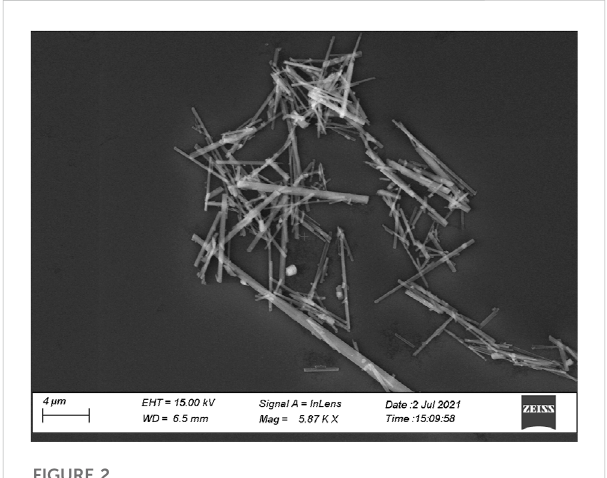
FIGURE 2 Secondary electrons SEM microphotograph of the synthetic amphibole used for the present